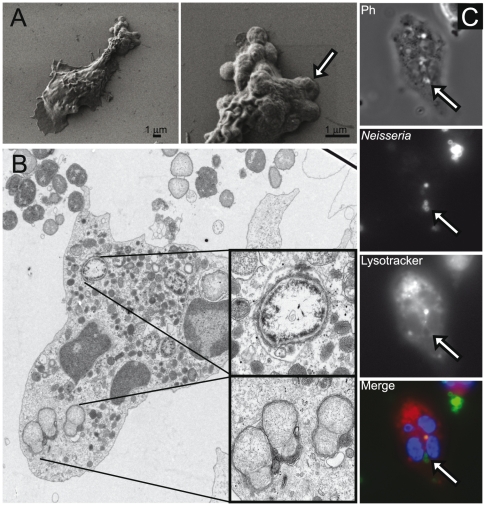
Bacteria invade PMNs via the uropod and intracellular bacteria can be found close to the uropod.(A) N meningitidis FAM20 were allowed to adhere to the uropod of freshly isolated PMNs. Left electron micrograph shows intracellular bacteria at the uropod. Right electron micrograph shows a magnified image of the cellular uropod at 16 000 x magnification of the same PMN. Arrow indicates an intracellular bacterium covered by the plasma membrane. (B) TEM image showing two cellular compartments in which intracellular bacteria reside. Upper enlarged box shows a bacterium inside a phagosome and the lower enlarged box shows a bacterium in a different compartment situated at the uropod. (C) DyLight NHS ester-stained N meningitidis FAM20 were allowed to adhere to the uropod of freshly isolated PMNs. Cells were stained with fluorescent labeled Lysotracker. An image of an infected PMN (phase contrast), DyLight NHS ester-stained intracellular meningococci (green), and acidic compartments (red) is shown. Arrows indicate bacteria.